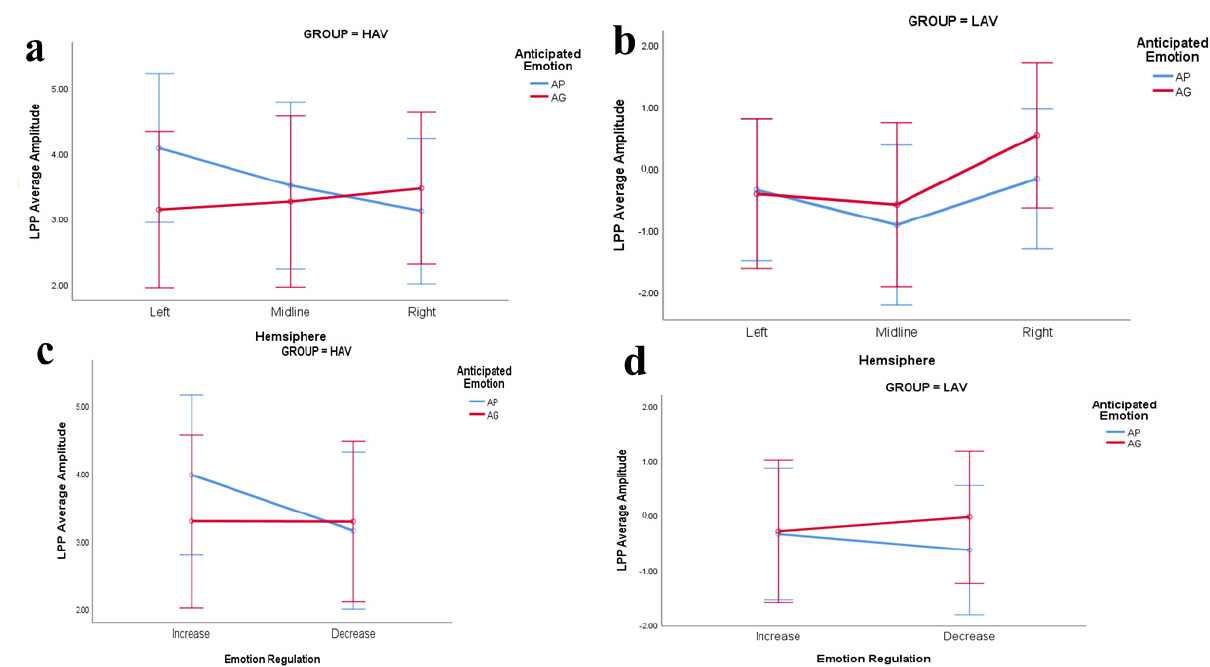
Figure 7. The interaction effects of the hemisphere, emotion regulation, and anticipated emotion for LPP. ( a , c ) The interaction of the hemisphere, emotion regulation, and anticipated emotion for LPP under the context of the HAV. ( b , d ) The interaction under the context of the LAV. Regarding HAV, when the participants received the message of decreased anticipated pride, there was no significant difference in the average amplitudes triggered by the emo- tion regulation among the hemispheres (see Table 7). In the HAV context, the difference in the lateralization of the left-middle-right brain regions was significant only when antici- pated pride was increased. In other emotion regulation situations (increasing anticipated guilt, decreasing anticipated pride, and decreasing anticipated guilt), the difference in lateralization processing was not significant. Table 7. Late positive potential (LPP) amplitudes (mean and standard error).